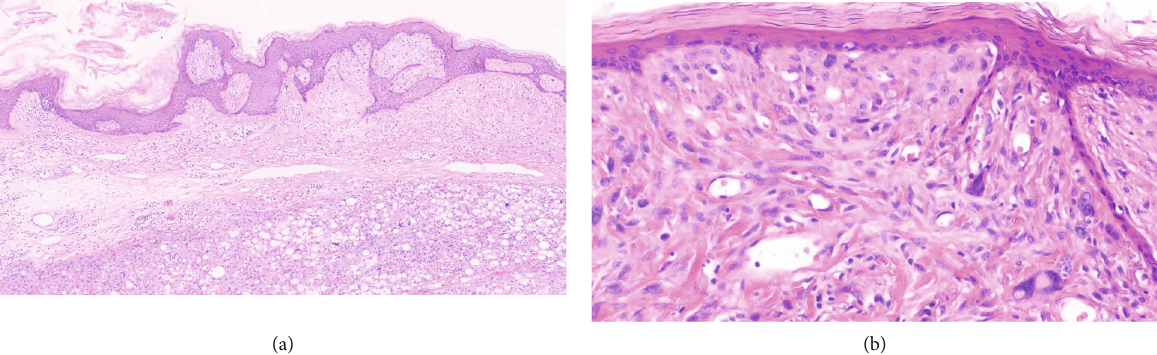
Figure 2: (a) Low power demonstrates a neoplasm abutting the epidermis composed of a hypocellular myxoid area overlying a more cellular area containing numerous univacuolar lipoblasts (H&E, 40x). (b) Sheets of spindle-shaped pleomorphic cells with enlarged hyperchromatic nuclei beneath the epidermis (H&E,